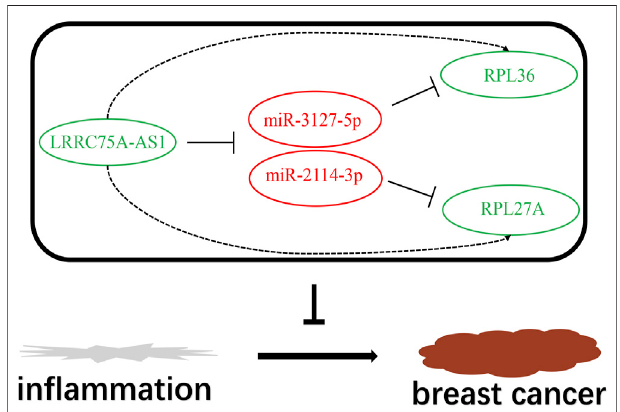
FIGURE 8 | The model of LRRC75A-AS1-mediated in fl ammation- related miRNA-mRNA pathways in breast